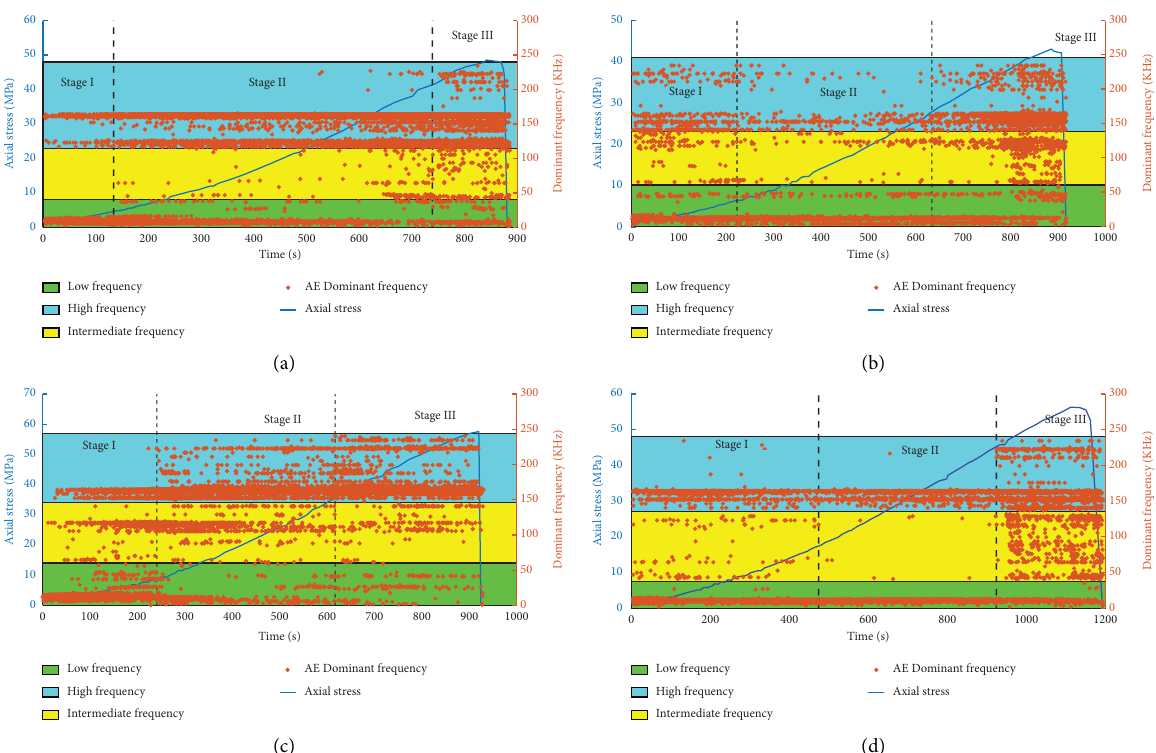
Figure 5: AE dominant frequency and axial stress evolution characteristics of sandstone with different pores over time. (a) QSY (c) FSY X . (d) FSY Z